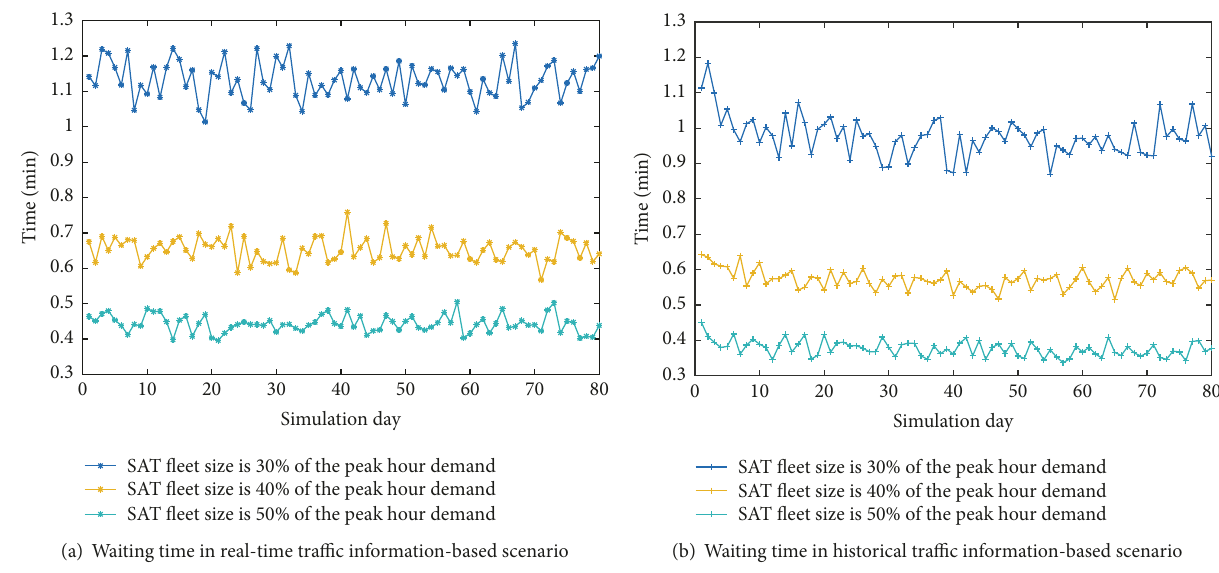
Figure 11: Day-to-day changes in waiting time for taxi requests in SATS with several SAT fleet